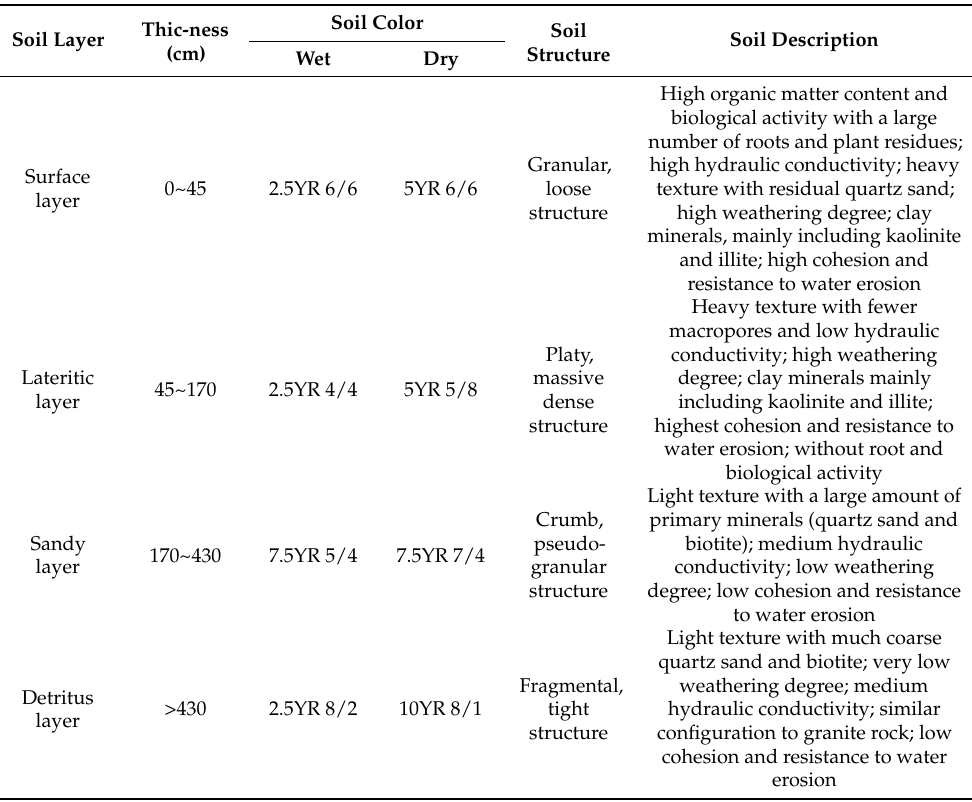
Table 1. Basic information about the selected soil